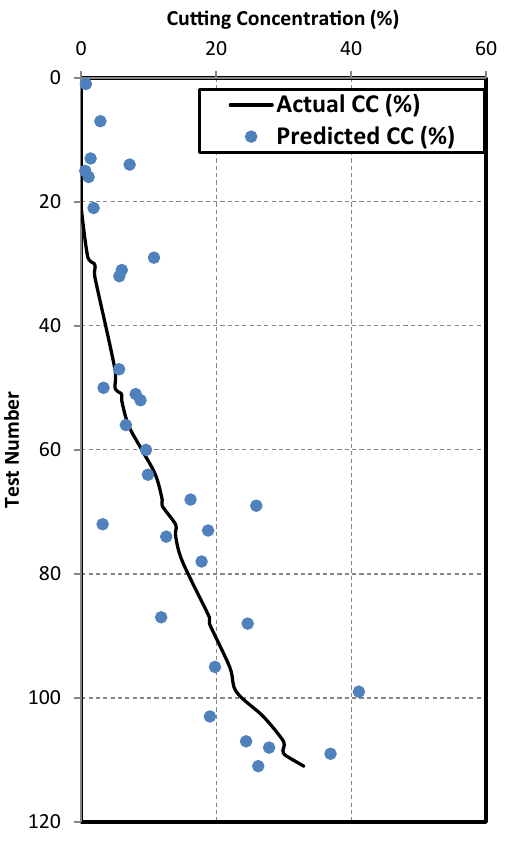
Fig. 10 Actual (experimental) and RBFN-predicted cutting concen- tration versus test number from testing stage